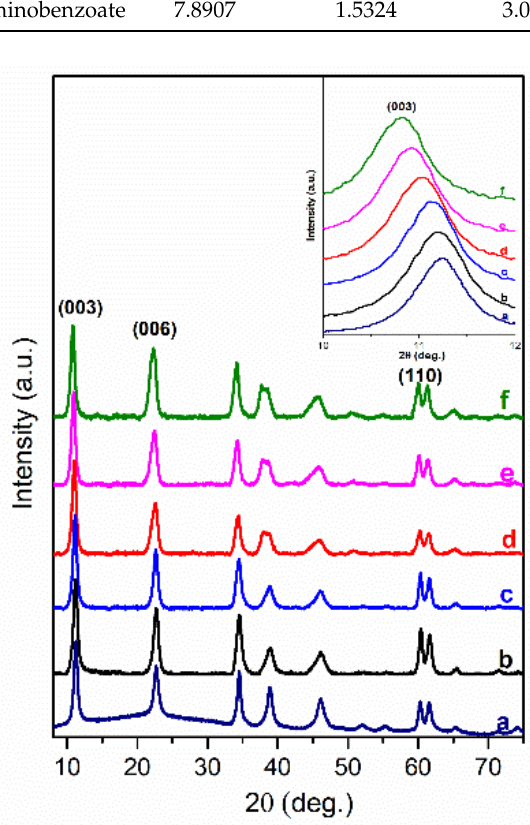
Figure 1. XRD patterns of Mg 3 /Al-CO 3 layered double hydroxides (LDH) ( a ) and Mg 3 /Al-CO 3 intercalated with organic anions: Mg 3 /Al-succinate ( b ), Mg 3 /Al-malonate ( c ), Mg 3 /Al-tartrate ( d ), Mg 3 /Al-laurate ( e ), and Mg 3 /Al-oxalate ( f ).